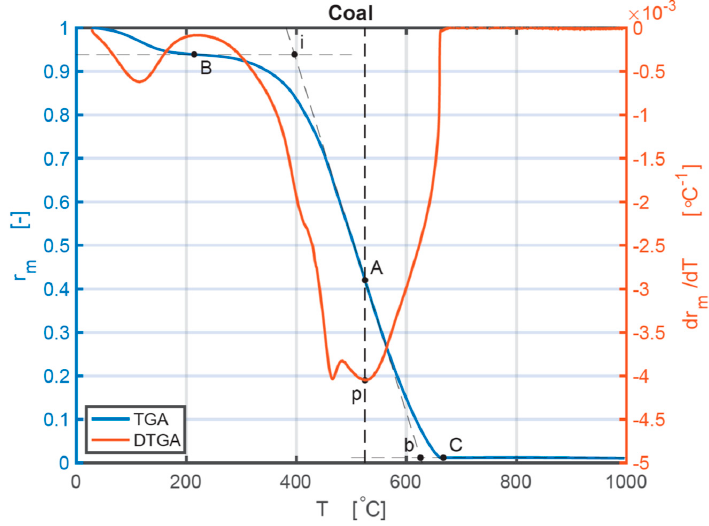
Figure 1. TG and DTG curves of the coal sample under 10 °C/min. Table 2. T i , T b , and T max of all